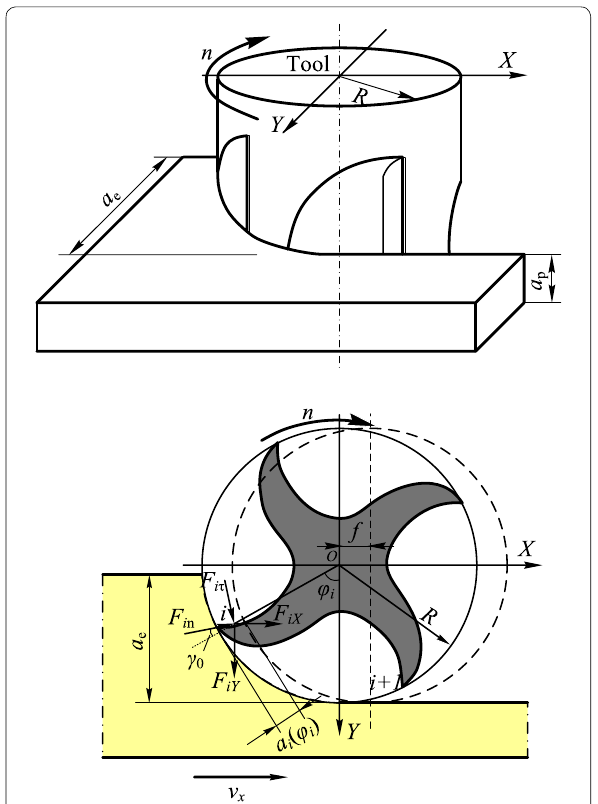
Figure 4 Cutting layer sketch of up